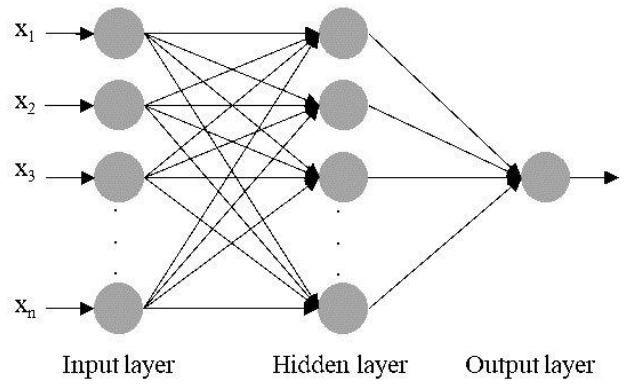
Figure 4 . The schematic of the feed - forward neural network with a single hidden layer . Figure 4. The schematic of the feed-forward neural network with a single hidden